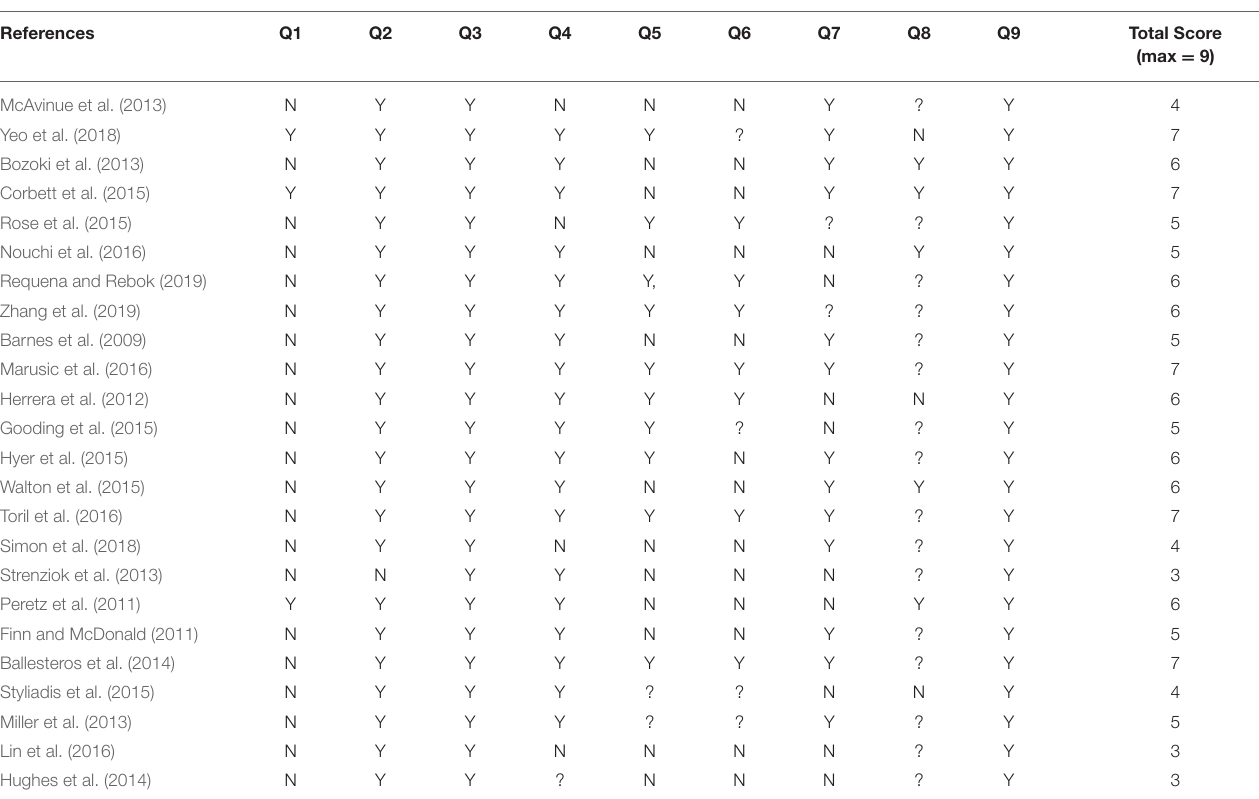
TABLE 1 | Scores of methodological